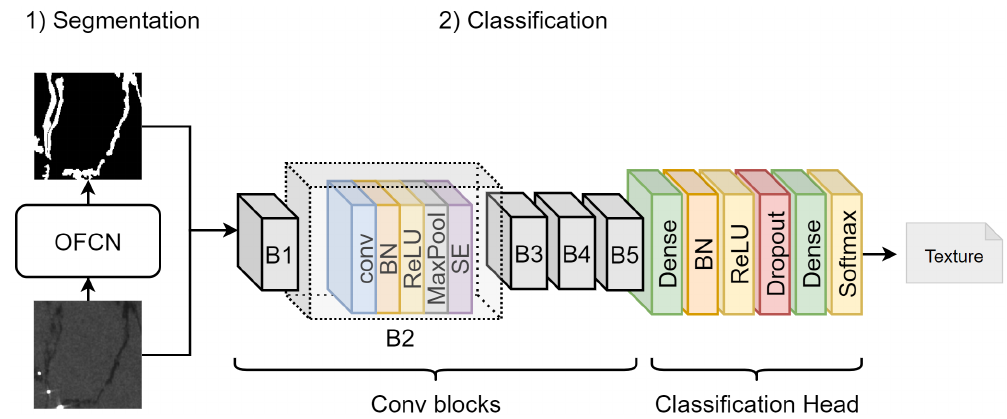
Figure 4. First the trained OFCN generates the segmentation masks from the SAR images. Then, both SAR images and predicted mask are fed in the classification network. A different architecture is trained to classify each one of the categories (e.g., the depicted one classifies the “texture”